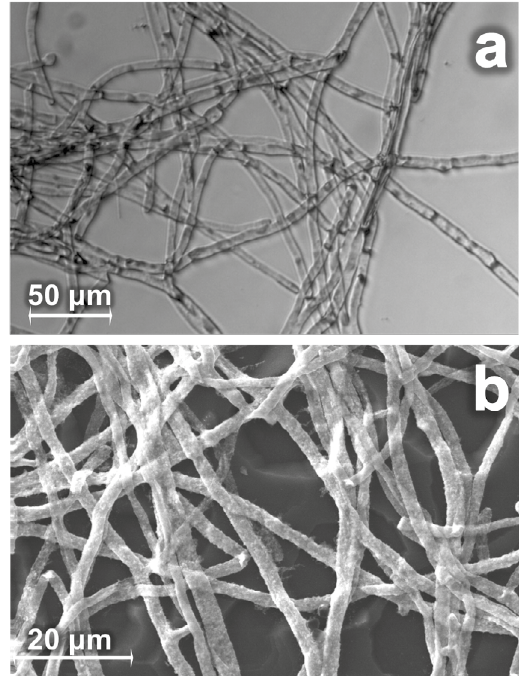
Figure 1. Optical micrographs of Aspergillus aculeatus before addition of AgNP and AuNP (a); scanning electron micrographs of the fungus after the addition of colloidal dispersions